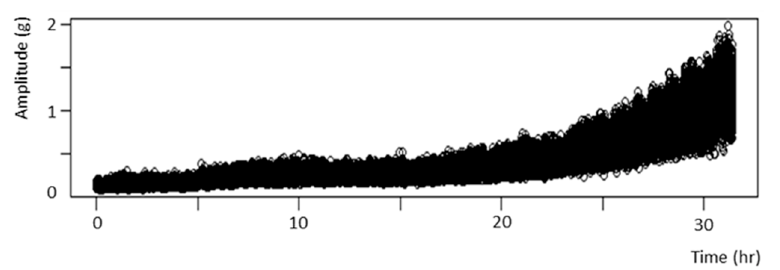
Figure 6. Raw data. Figure 6. Raw data.